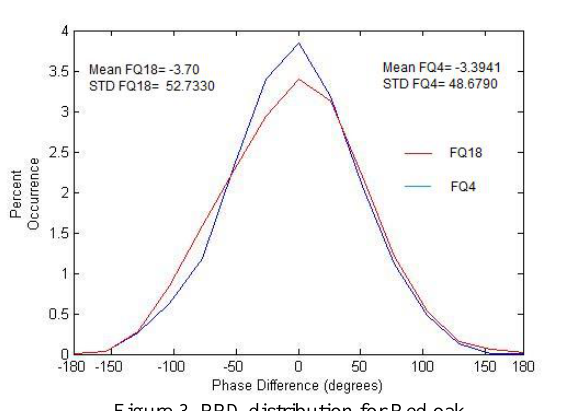
Figure 3. PPD distribution for Red oak